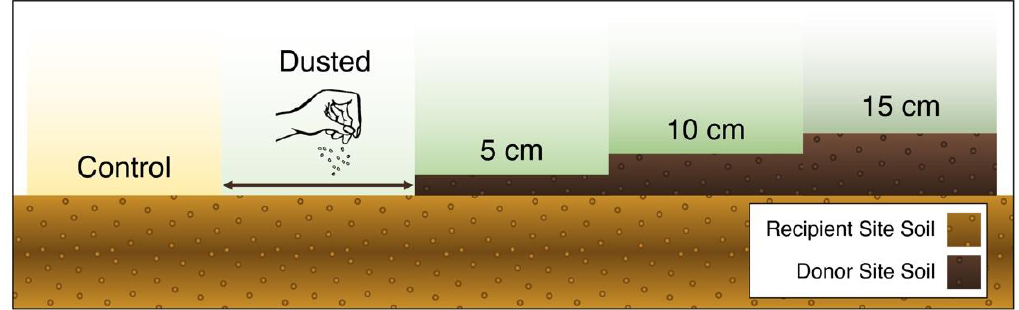
Figure 2. Experimental blocks represented all salvaged-soil deposition-depth treatments, here depicted from a side view. Soil salvaged from the intact donor site was deposited on top of existing soil at the degraded recipient site. Control plots received no salvaged soil, while dusted plots received only a dusting of soil. Plots of 5, 10, and 15 cm received a salvaged soil layer of the stated depth. Due to the germination of natives following the initial data collection e ff ort, as well as to determine Soil deposition occurred at recipient sites in December 2015, in proportion to their total area the e ff ect of treatment over time, additional plant community data were collected in March 2016, and then again in March 2017. Count data were taken in 1 × 1 m quadrats placed in the center of each study plot, avoiding areas with disturbances. For each native species, all individual plants were counted